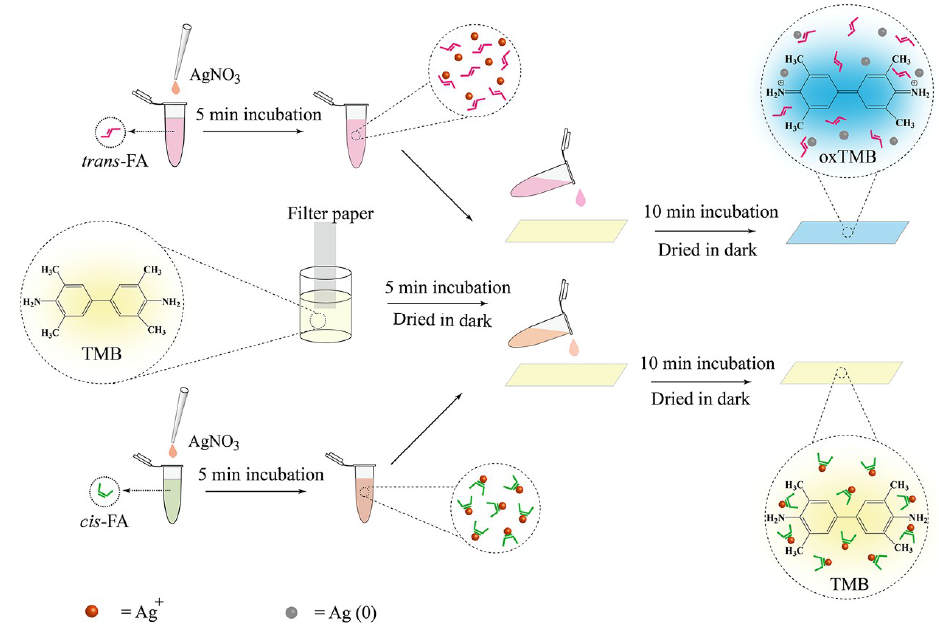
Scheme 1. Illustration of the mechanism of test paper for colorimetric inspection of FAs according to the color changes of TMB induced by Ag + oxidation.